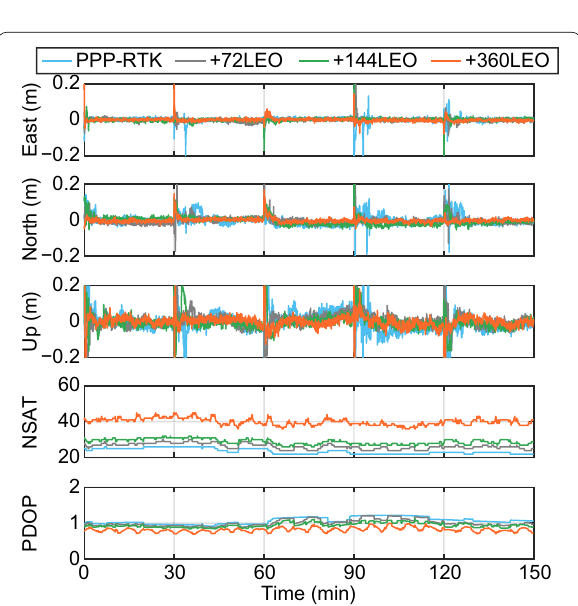
Fig. 13 Positioning series of PPP-RTK with the augmentation of different LEO constellations for an 800 km spaced